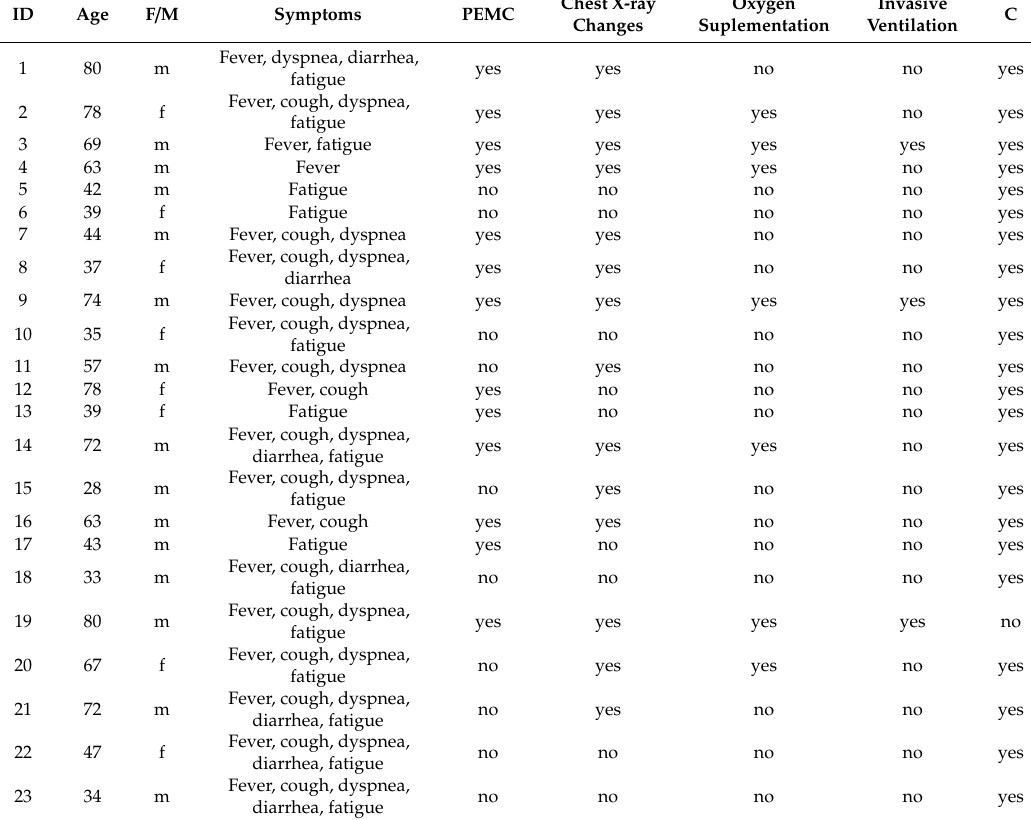
Table 1. Patients’